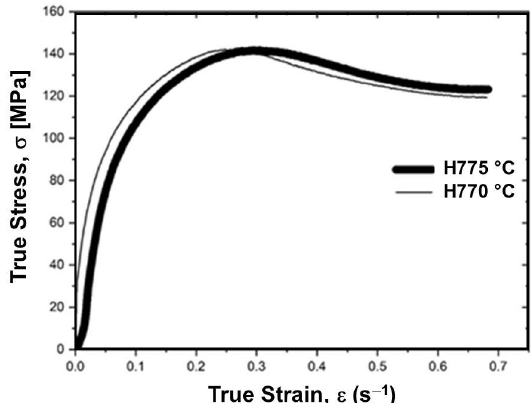
Figure 6. Comparison between experimental (points) and predicted (solid lines), flow curves at different temperatures and strain rate, Figure 7. Intersection between 2 experimental curves at 755°C and 770°C at strain rate 0.01 s -1 for medium carbon steel.